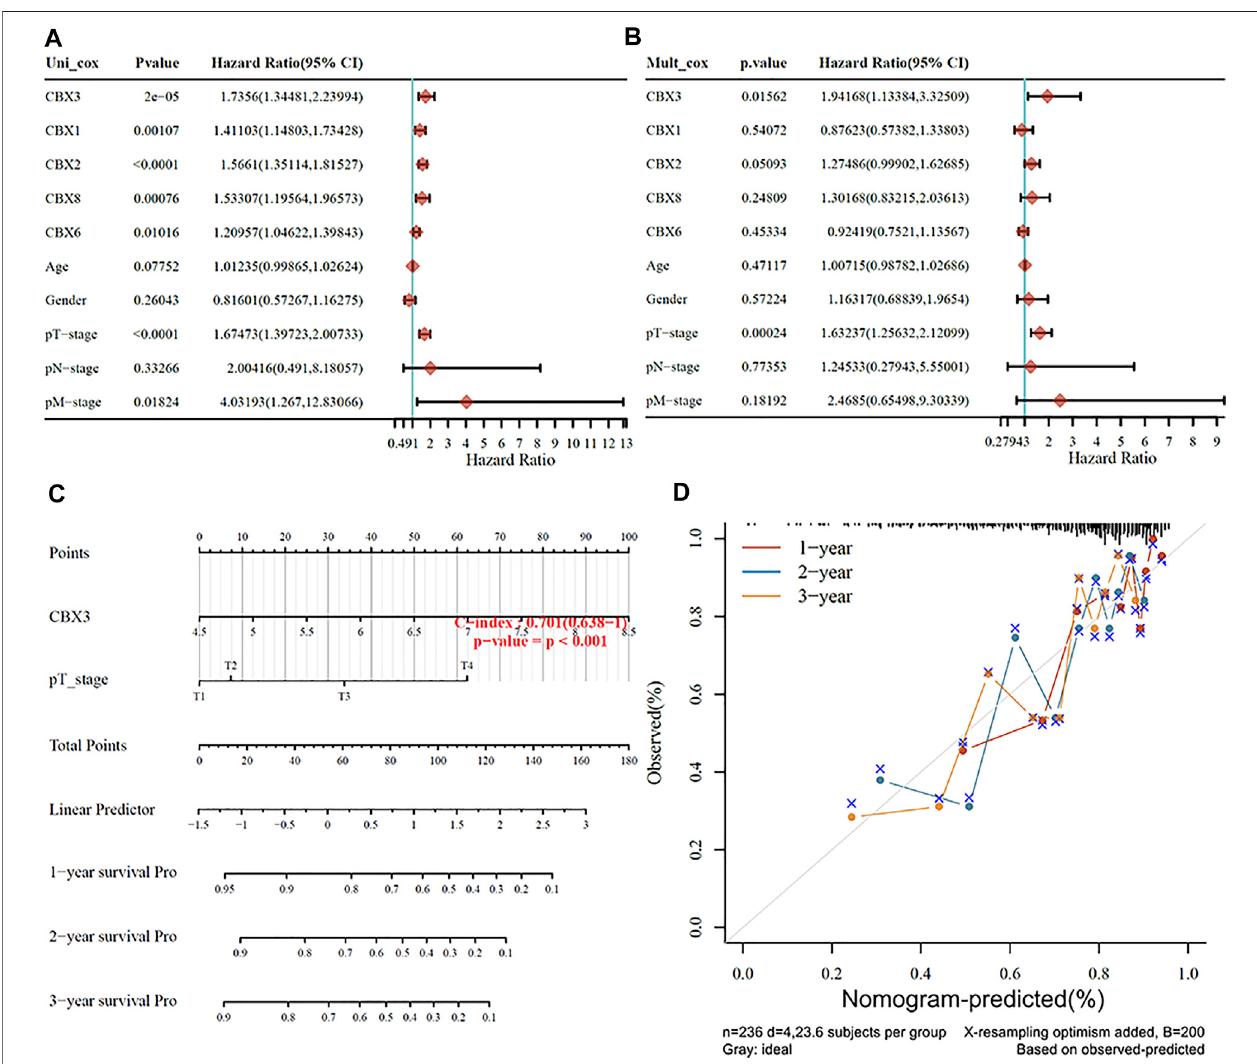
FIGURE 4 | (A,B) Hazard ratios and p values for the components included in univariate and multivariate Cox regression analyses of HCC clinical variables and fi ve prognostic CBXs. (C,D) Nomogram to estimate the overall survival rate of HCC patients at one, three, and 5 years. Calibration curve for the discovery group ’ s overall survival nomogram model. The ideal nomogram is shown by a dashed diagonal